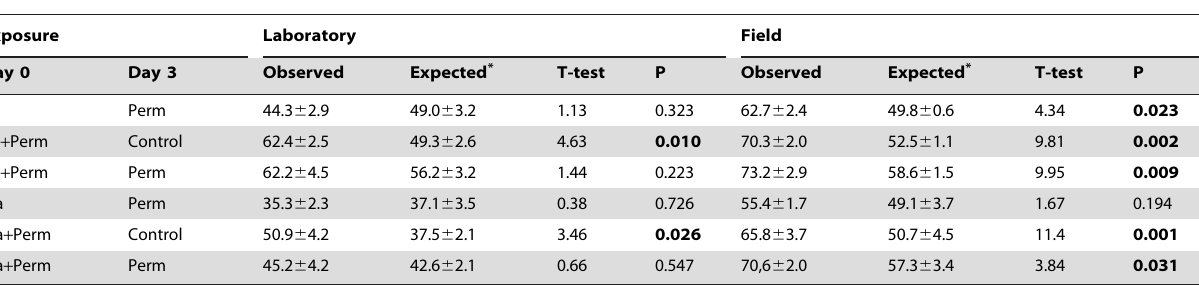
Table 2. Synergistic interactions between fungus and